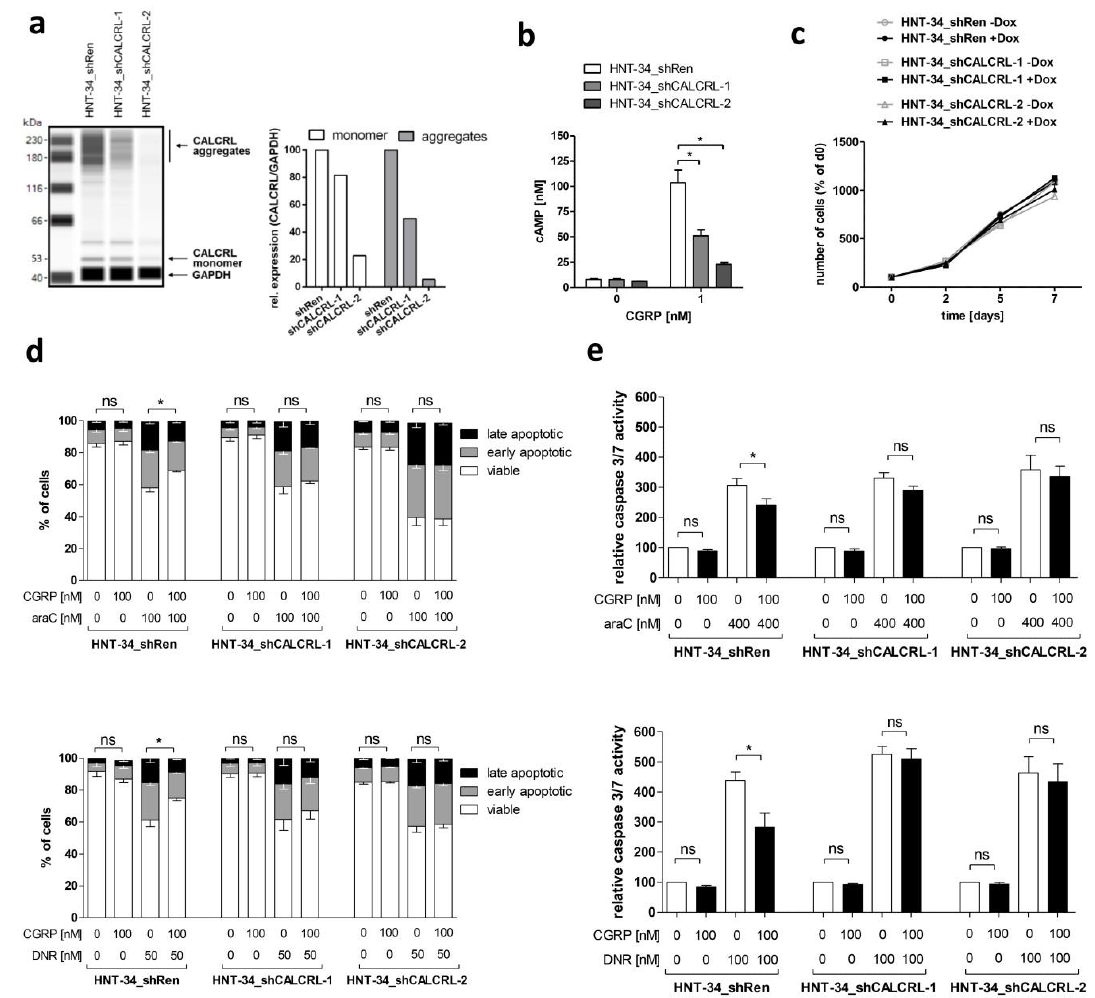
Figure 3. Genetic inhibition of CALCRL counteracts the CGRP-induced increase in chemotherapy resistance. CALCRL was knocked down in HNT-34 cells using lentivirus-borne, doxycycline inducible shRNAs. Unless indicated otherwise, experiments were performed after pre-incubation with and in the presence of doxycycline. ( a ) Expression of CALCRL in HNT-34_shRen, HNT-34_shCALCRL-1, and HNT-34_shCALCRL-2 was determined by capillary-based protein quantification analysis (Wes). Left panel, Wes plot; right panel, quantification. Protein aggregates are frequently observed with G-protein coupled receptors. ( b ) cAMP levels after stimulation of serum starved HNT-34_shRen, HNT-34_shCALCRL-1, and HNT-34_shCALCRL-2 with 0 or 1 nM CGRP for 2 min. Means + SEM from 3 biological replicates. * p < 0.05; paired Student’s two-tailed t-test. ( c ) Proliferation of HNT-34_shRen, HNT-34_shCALCRL-1, and HNT-34_shCALCRL-2 in the absence and presence of doxycycline. Means +/ − SEM from 3 biological replicates (error bars do not exceed data point symbols in most cases). ( d , e ) CALCRL knock-down diminishes CGRP mediated protection from araC- and daunorubicin (DNR)-induced apoptosis. Cells were pre-incubated with or without 100 nM CGRP for 1 h prior to addition of the indicated concentrations of cytostatic drugs. Means +/ − SEM from 3–4 biological replicates. ns, not significant, * p < 0.05, paired Student’s two-tailed t -test. ( d ) AnnexinV / DAPI assay. Significance indicators refer to the proportion of viable cells. ( e ) Caspase 3 / 7